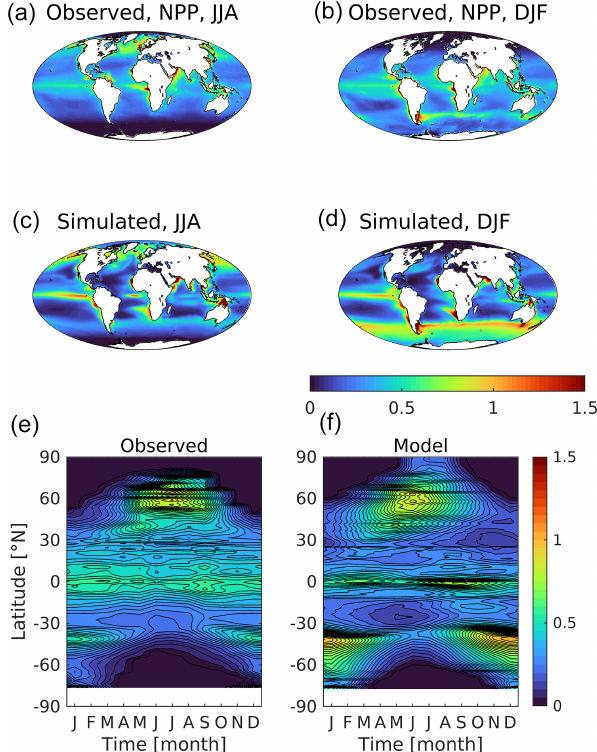
Figure 14. Observational (a, b) and simulated (c, d) vertically in- tegrated net primary production shown geographically for northern ( a, c ; JJA) and southern summer ( b, d ; DJF) and as zonal Hov- möller diagrams (e, f) . Missing observational data at high latitudes are shown as zero because of polar night or sea ice. Primary pro- duction is given in gCm − 2 d − 1